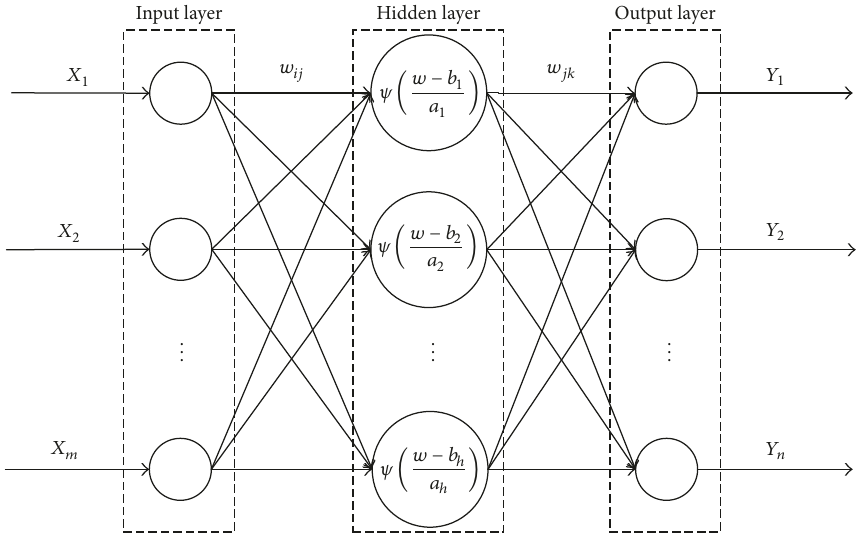
Figure 3: The network topology of